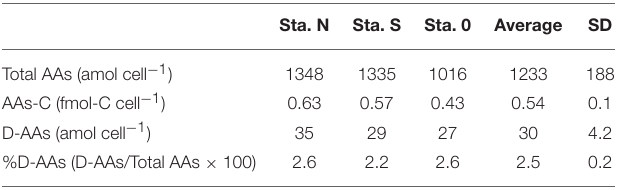
TABLE 4 | Cellular contents of total AAs and carbon in the form of AAs (AAs-C) and D-AAs in bacteria-sized particles collected at three stations.